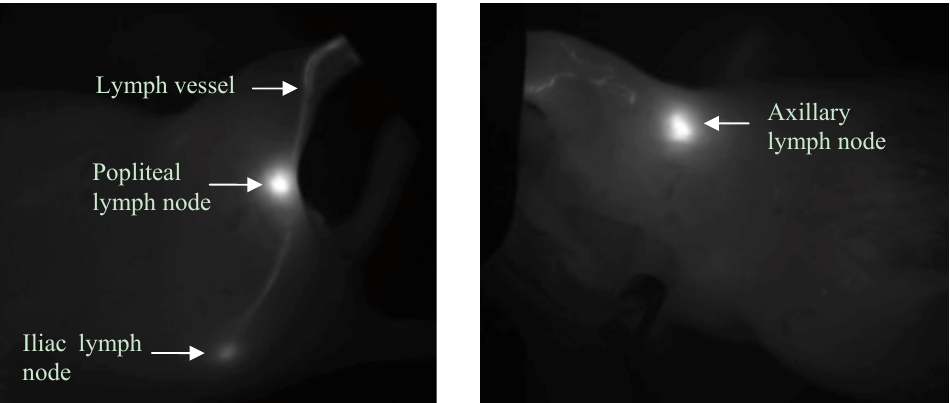
Figure 3. Representative in vivo fluorescent images after s.c. injections into the footpad (left panel, upper node is popliteal, lower is iliac), and forearm (right panel, axillary nodes) of HA-IR820 conjugates. Both the lymph nodes and draining lymphatic capillaries can be visualized using in vivo imaging with HA-IR820 conjugates. The injection sites were masked in the images in order to visualize the details in the lymphatic